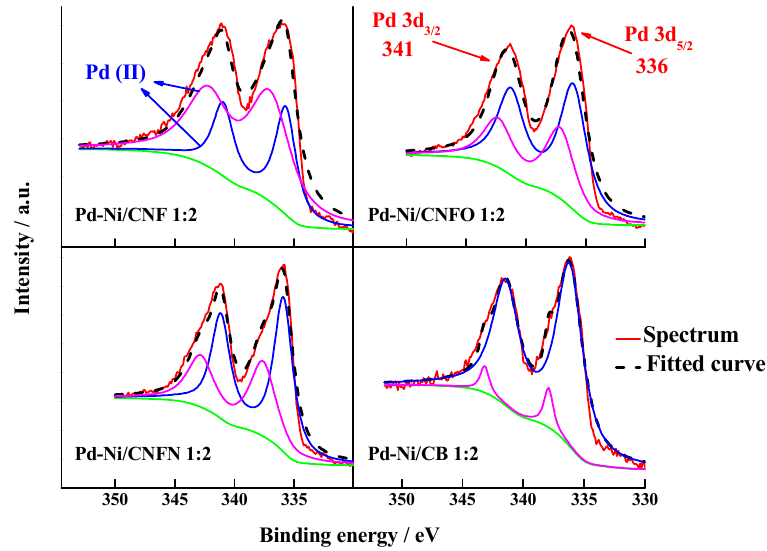
Figure 5. Pd 3d XPS spectra for the synthesized Pd-Ni catalysts supported on carbon nanofibers and carbon black.